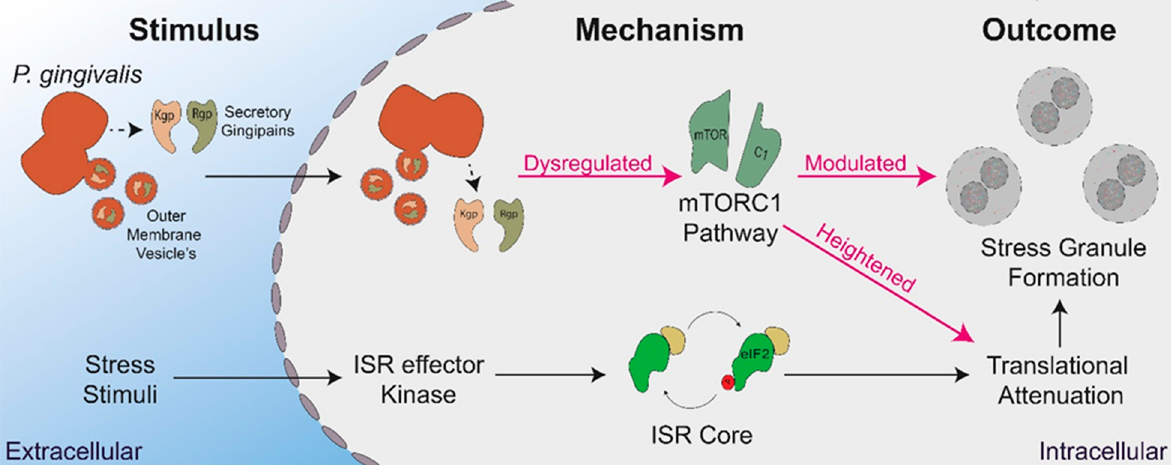
Figure 8. Summary of P. gingivalis interactions with host stress-induced translational control. Stress stimuli, such as oxidative stress, activate ISR effector kinases with phosphorylate eIF2 ɑ , resulting in translational attenuation and stress granule formation. P. gingivalis secretes gingipains and outer membrane vesicles in a both extra- and intracellular manner, which dysregulate the mTORC1 pathway, leading to heightened translational attenuation and modulated stress granule formation.